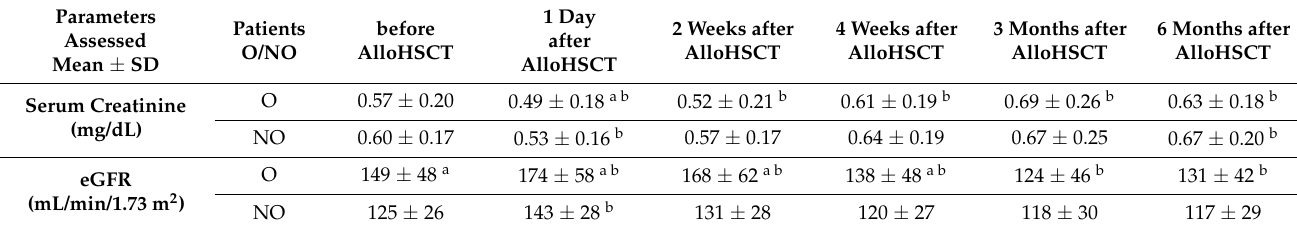
Table 2. Mean serum creatinine and estimated glomerular filtration rate (eGFR) values in examined groups. Parameters Patients Assessed Mean ± SD